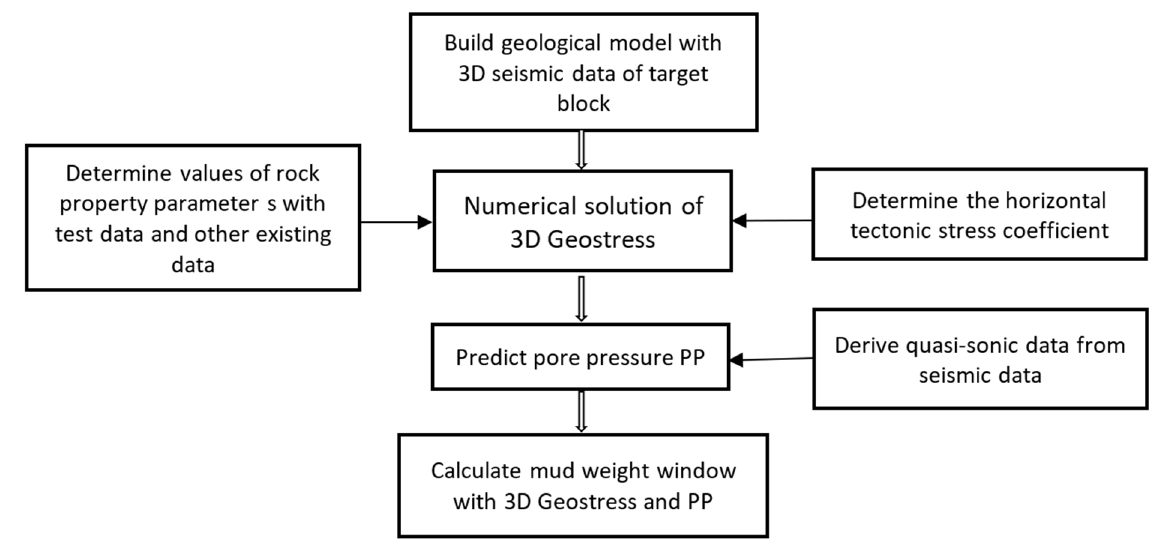
Figure 3. Illustration of workflow of integrated 1D geomechanical analysis of pilot well and 3D geostress analysis.